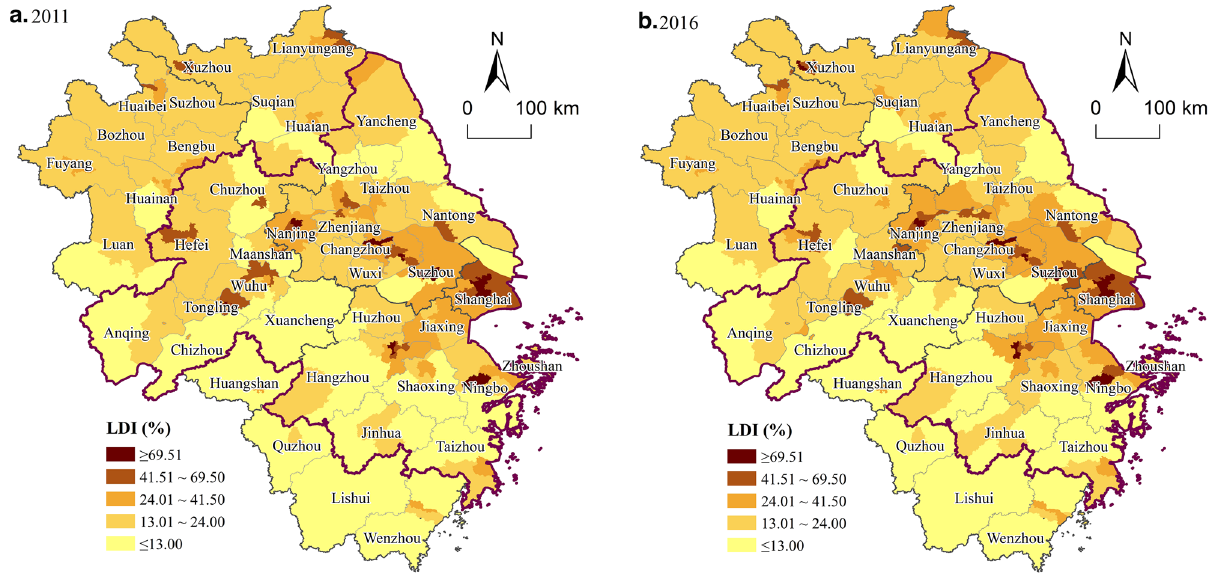
Figure 5. The spatial distribution of the LDI at the county level in YRD. ( a ) 2011; ( b ) 2016. Software: Arcgis 10.7. URL: https:// www. esri. com/ zh- cn/